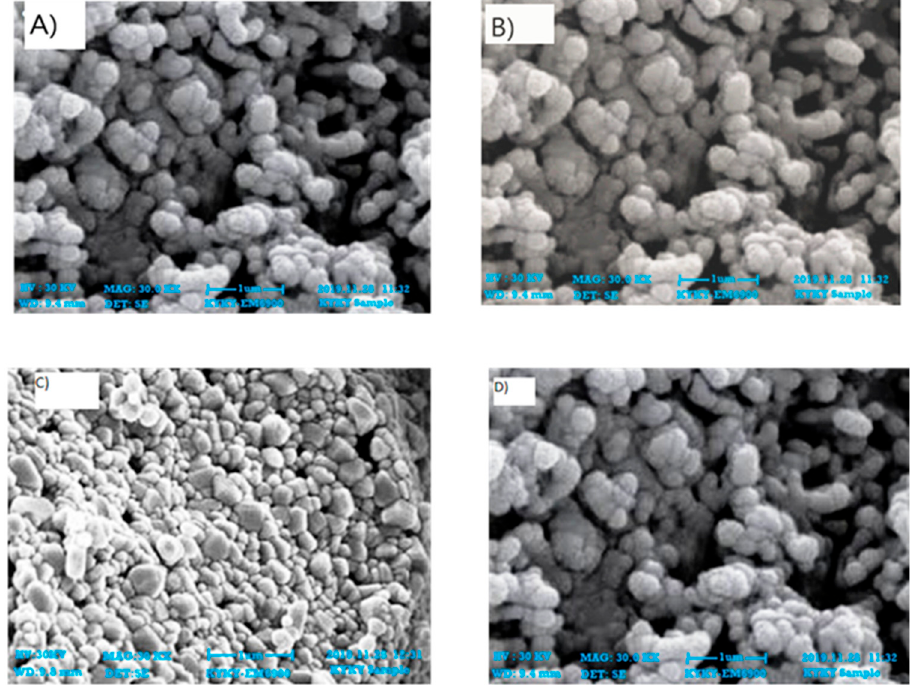
Figure 4. SEM images of zinc oxide nanoparticles of fruits: ( A ) n-hexane, ( B ) ethyl acetate, ( C ) methanol, and ( D ) aqueous extracts.